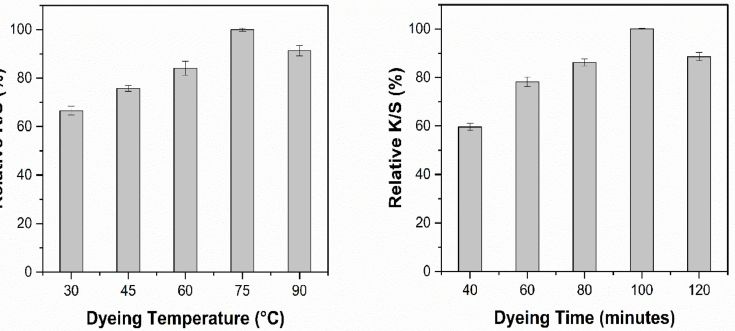
Figure 8. Effect of dyeing conditions on the relative K/S obtained with NaOH extract.